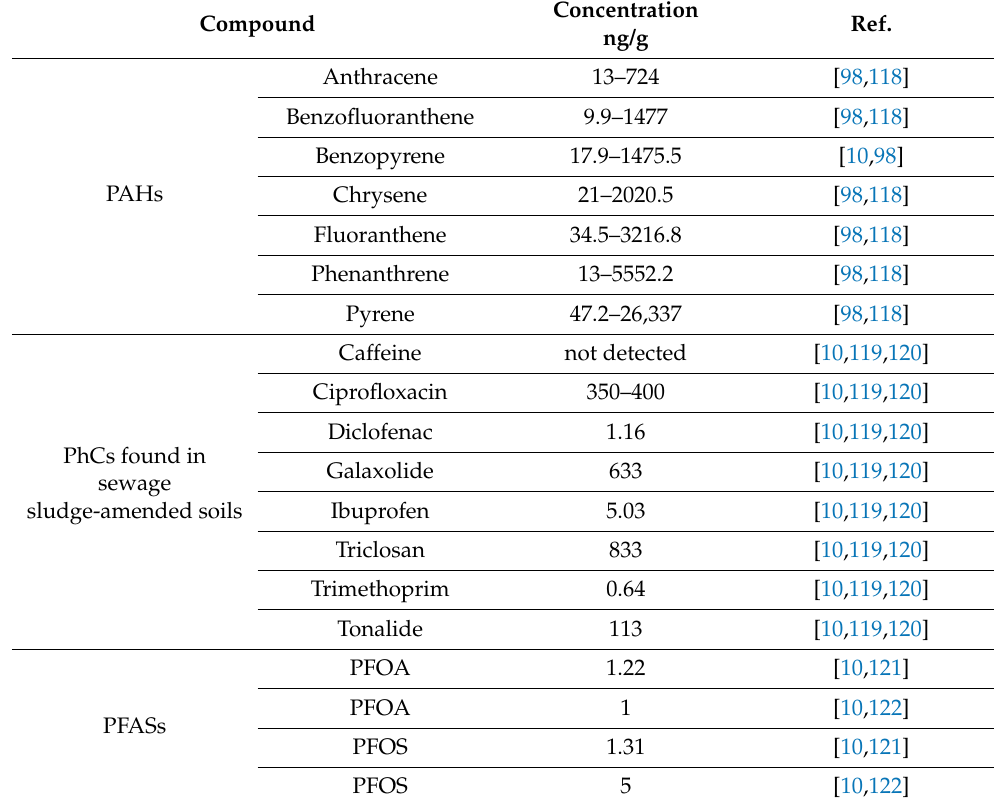
Concentration ng/g